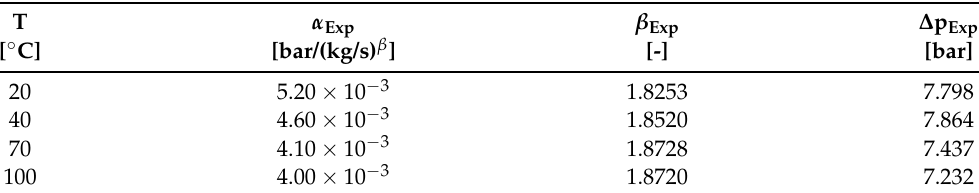
Table 2. OVT extrapolated pressure drops for the different test temperatures at the reference mass flow rate of 54.95